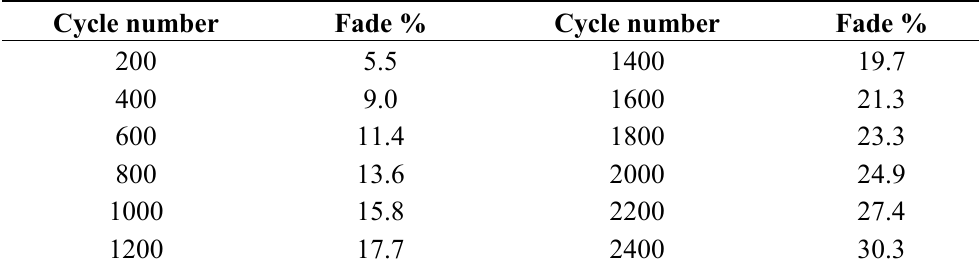
Table 1. Capacity fade (%) with respect to the cycle